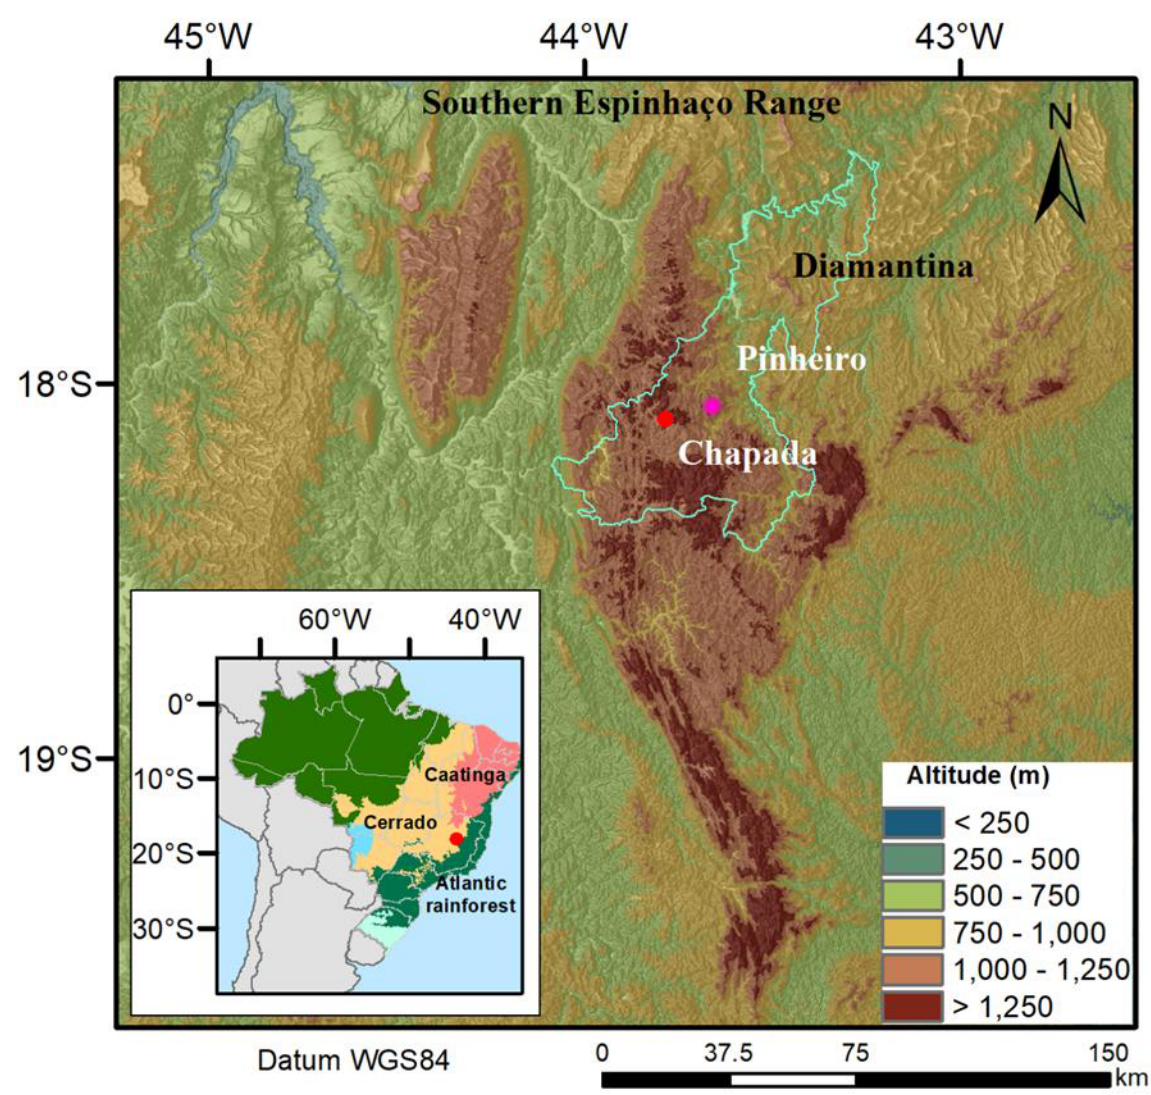
Figure 1. Locations of the studied peatlands (Pinheiro and Chapada) in the Serra do Espinhaço Meridional, Minas Gerais (MG) state, south-eastern